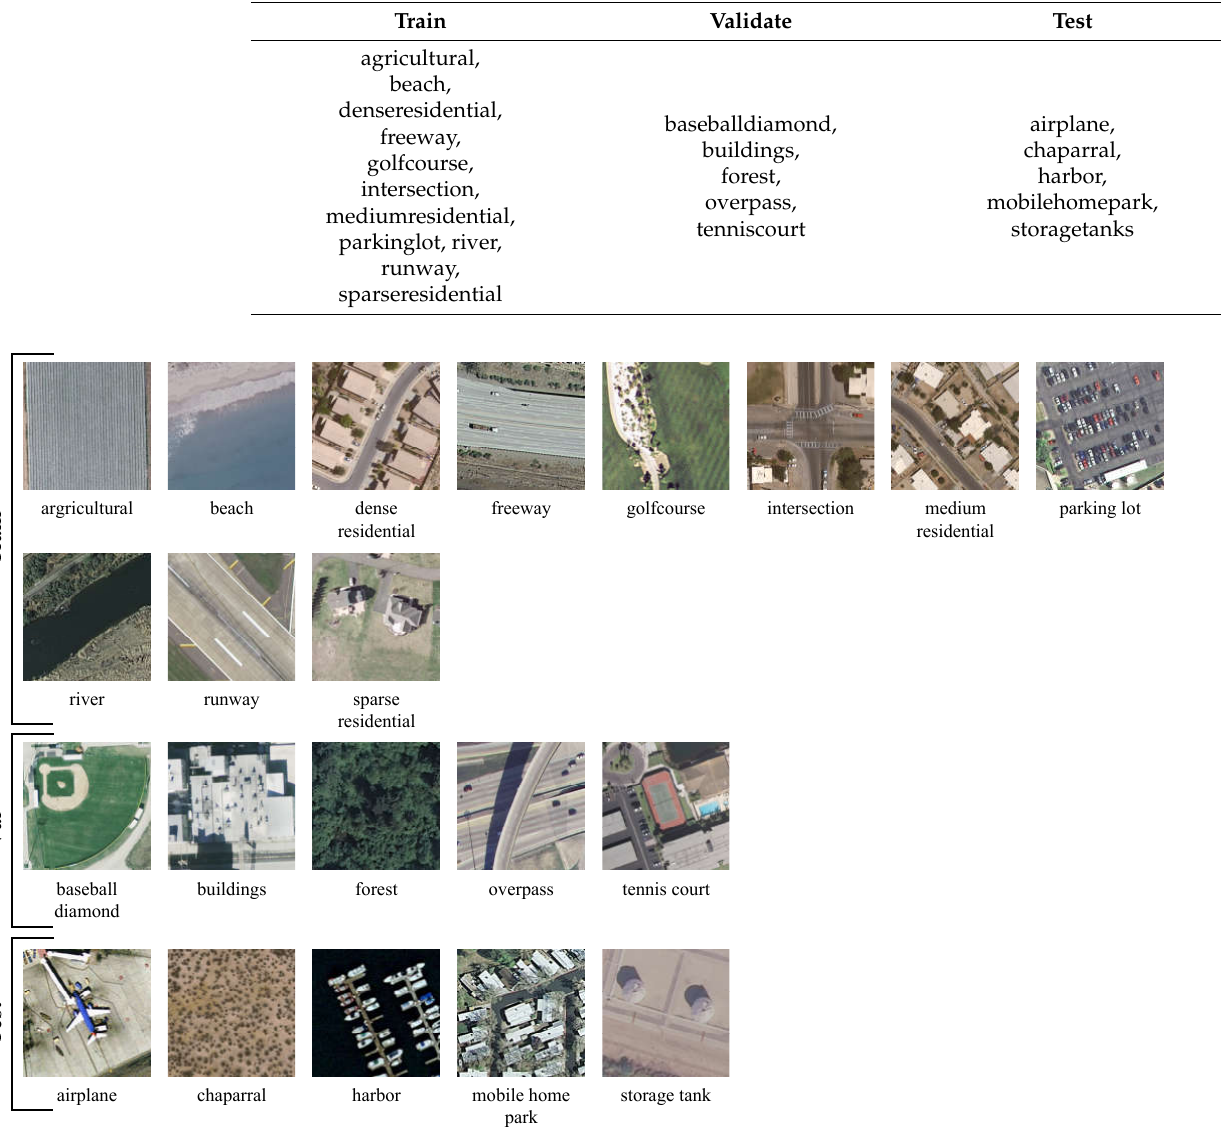
Figure 6. The train, validate, and test partitions of dataset UC Merced. NWPU-RESISC45 [79] is a public scene classification dataset published in 2017 by Northwestern Polytechnical University (NWPU). There are 45 scene categories containing an airport, tennis field, residual places, snow mountains, and seas, with 700 images in